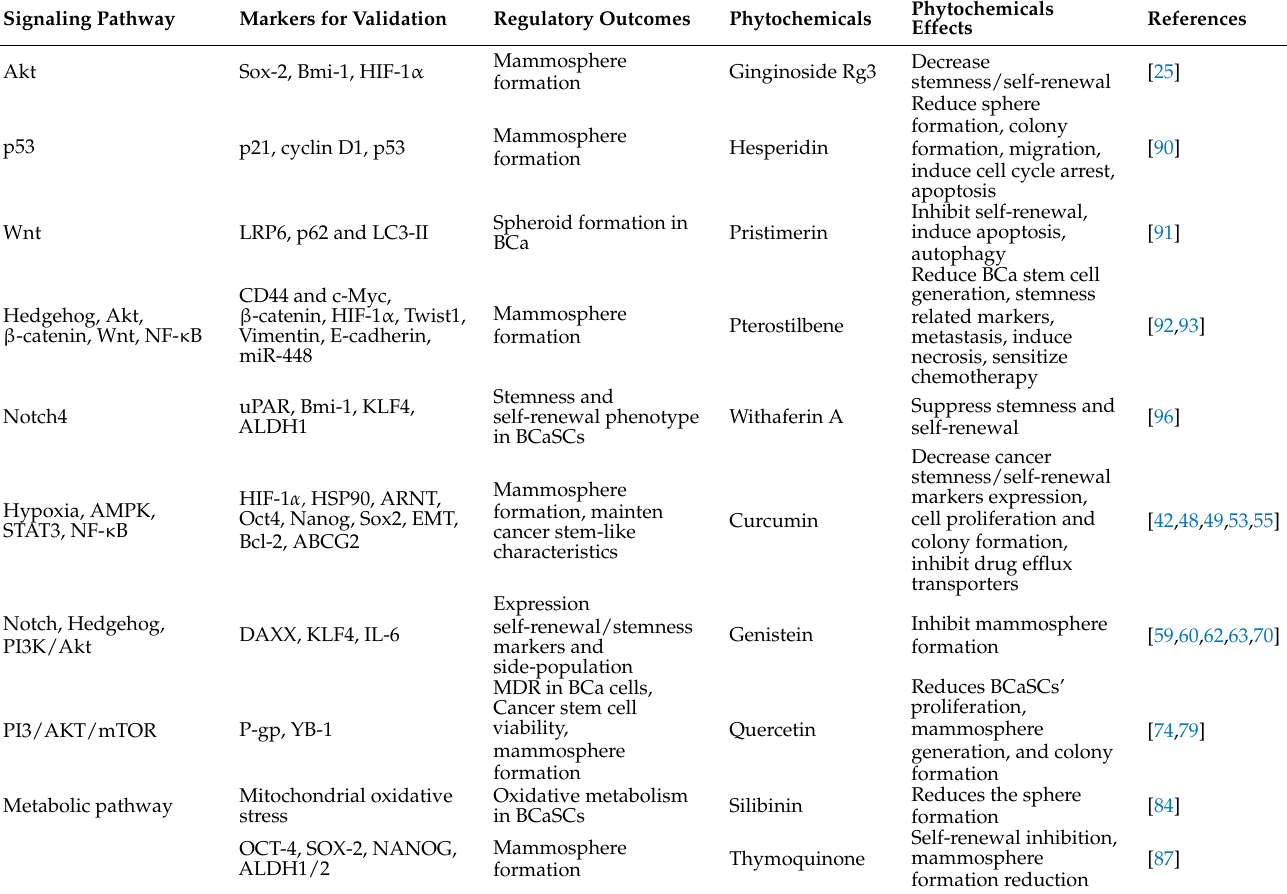
Table 2. Stemness/self-renewal signaling regulations by dietary phytochemicals in luminal A-derived